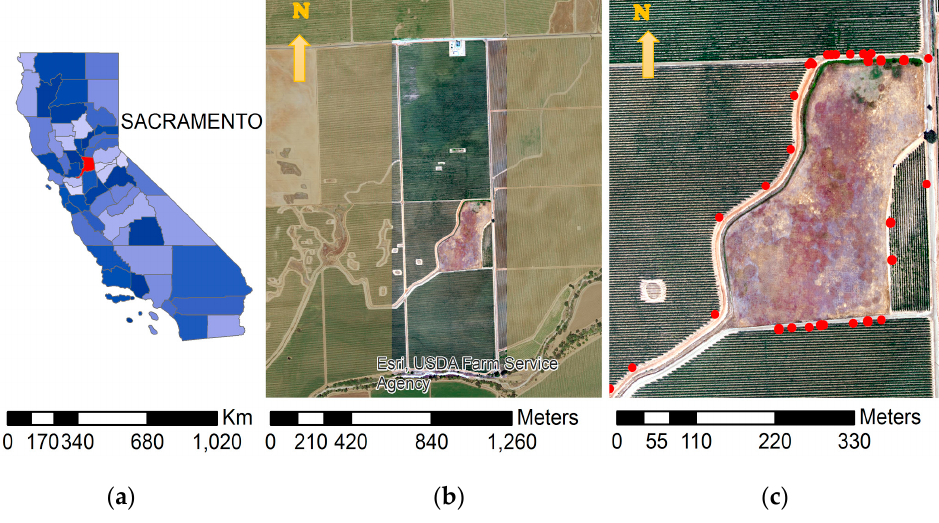
Figure 2. Location of the study area: County location in California ( a ); AggieAir sUAS coverage area in RGB mosaic for all flights ( b ); and close view of sUAS RGB mosaic along with ground temperature sampling locations (dots) ( c ).